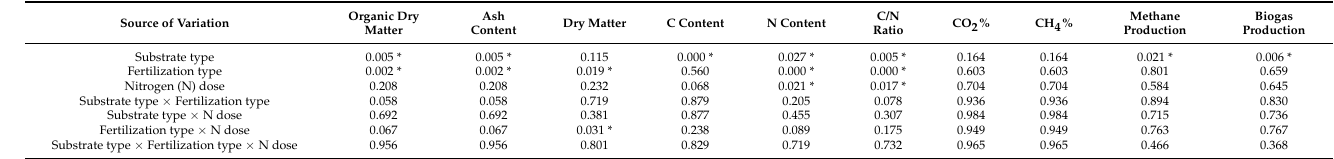
Table 4. Analysis of variance ( p values) for the analyzed features.